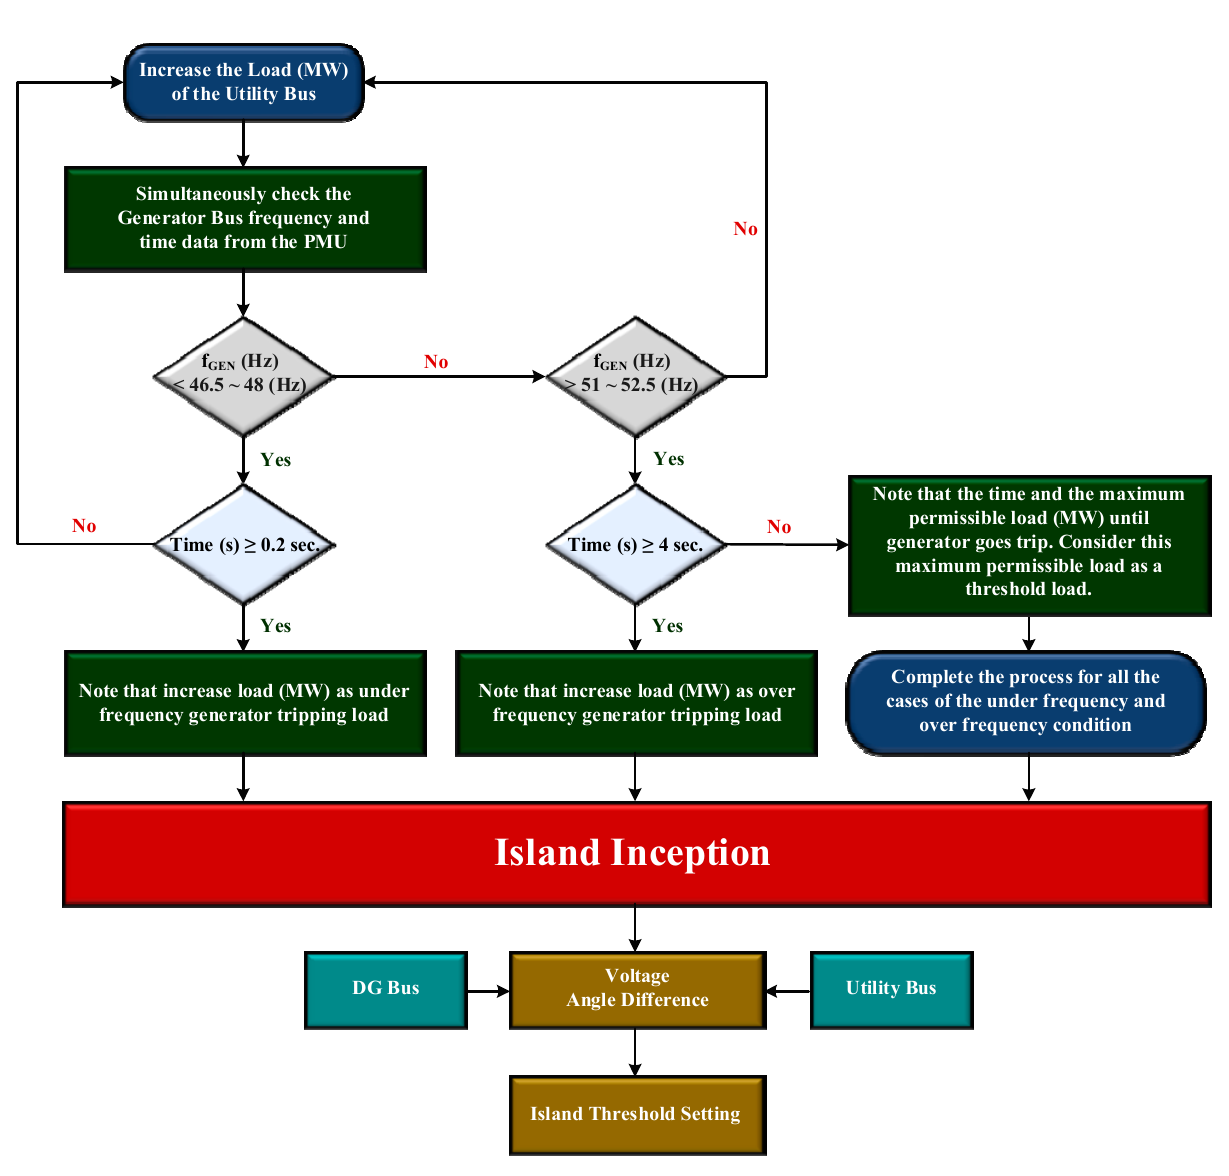
Figure 1. Proposed flow diagram of the island threshold technique.